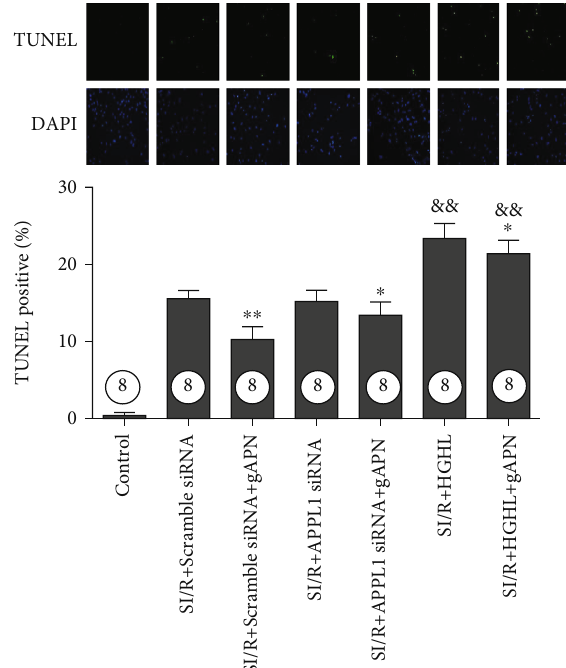
Figure 7: Inhibition of APPL1 expression partially mimicked APN resistance in HGHL-treated neonatal cardiomyocyte. Cardiomyocyte apoptosis was determined by TUNEL staining. ∗ P < 0 : 05 ; ∗∗ P < 0 : 01 vs. the same treatment group without gAPN. && P < 0 : 01 vs. the same treatment group without HGHL (with scramble